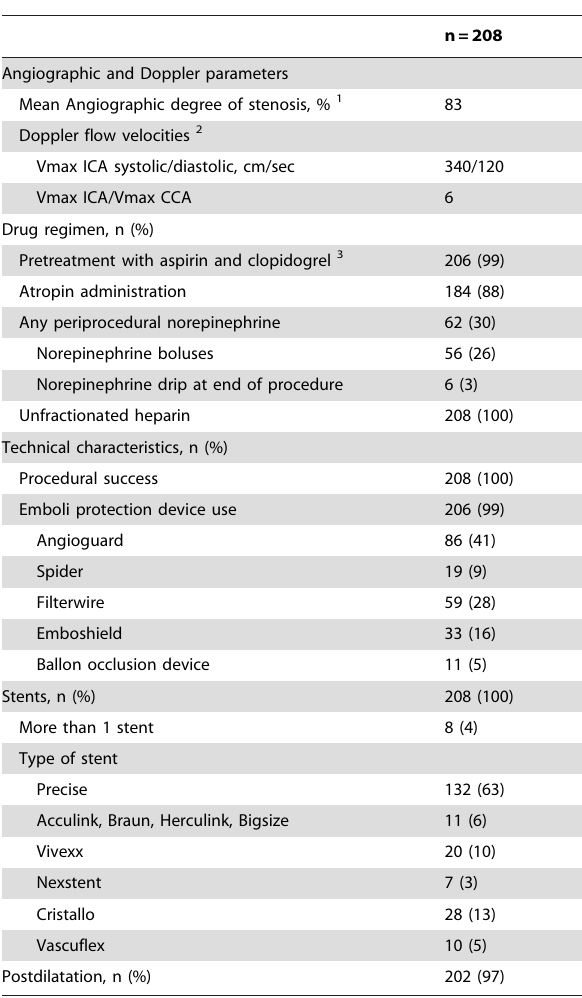
Table 2. Procedural Data.